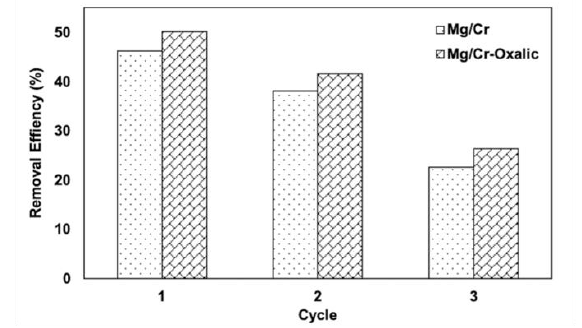
Fig. 8. Regeneration of malachite green on Mg/Cr LDH and Mg/Cr- (COO) 22- e